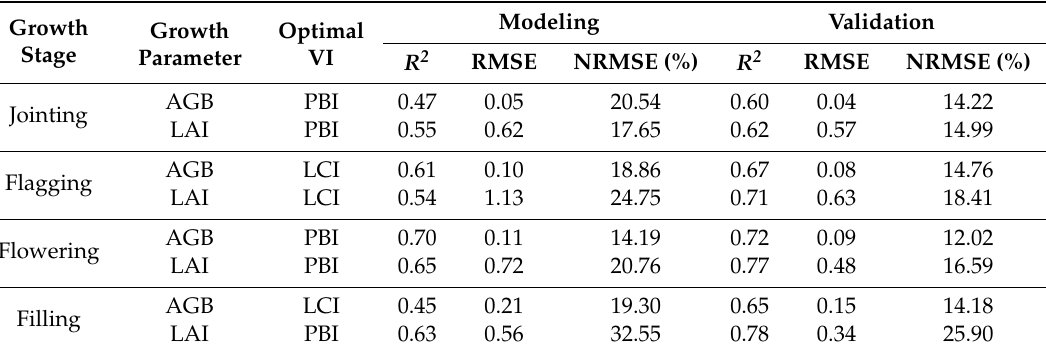
Table 4. Performance metrics for the estimates of winter-wheat growth parameters (AGB and LAI) obtained using the optimal vegetation indices for di ff erent growth